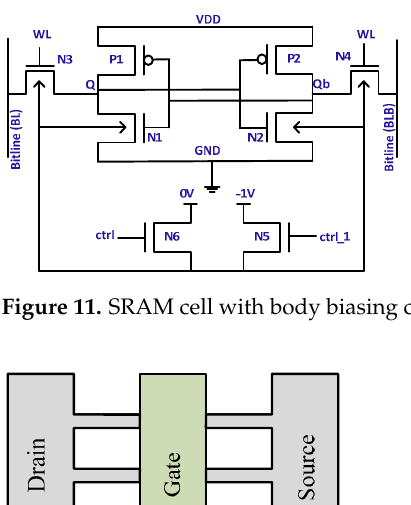
Figure 11. SRAM cell with body biasing control circuit [48].